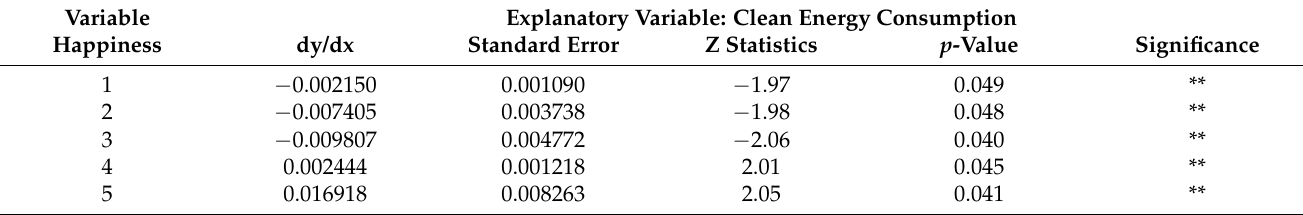
Table 5. Marginal